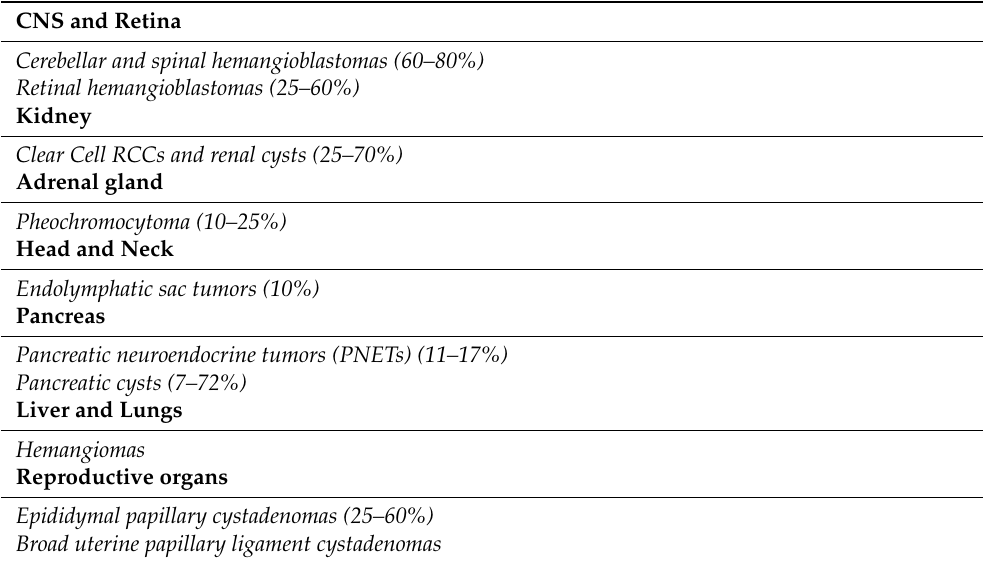
Table 4. Typical VHL-associated tumors and related frequency